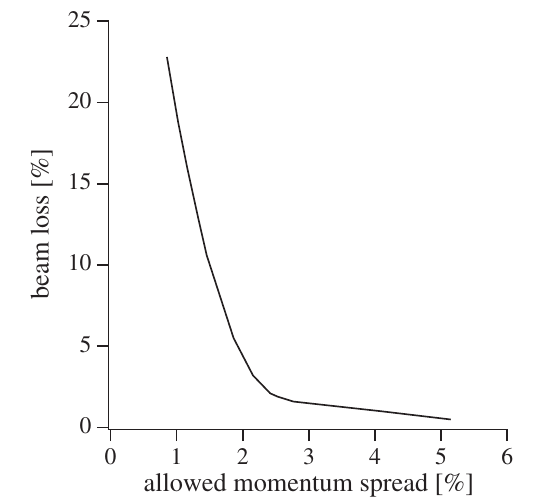
FIG. 9. Beam loss as a function of allowed momentum spread. If a muon storage ring downstream has enough momentum acceptance, beam loss becomes